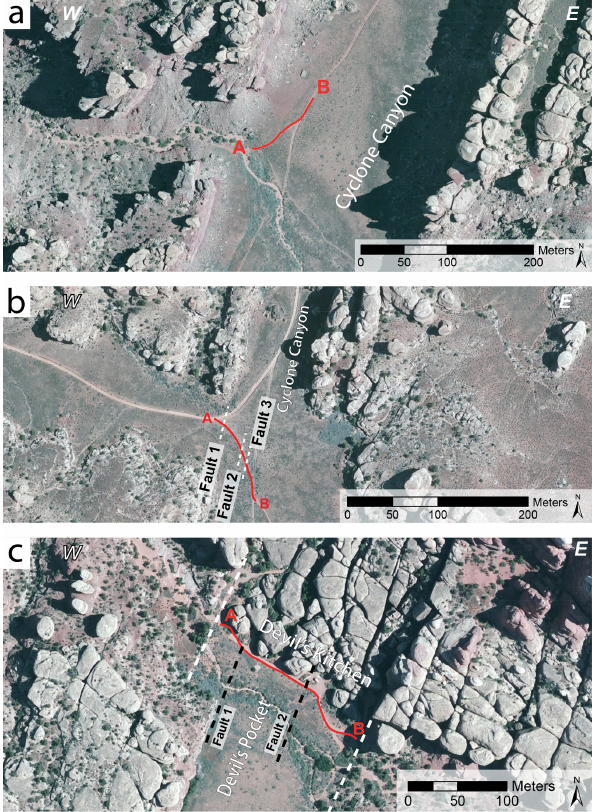
Figure 11. Photo plate showing the traces of GPR profiles in (a) northern Cyclone Canyon, (b) central Cyclone Canyon and (c) Devil’s